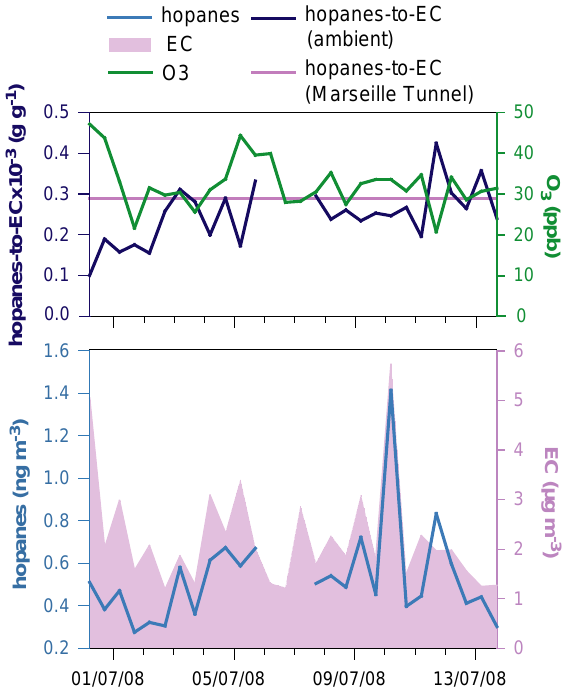
Fig. 9. Time series of EC and sum of hopane (17 α (H)- Fig. 9 21 β (H)-norhopane, 17 α (H)-21 β (H)-hopane and 17 α (H)-21 β (H)- 22S-homohopane). The Ambient concentration ratios of Hopanes- to-EC observed at Marseille (dark blue) are compared to the ratio specific of vehicular emissions in France (green) (El Haddad et al., 2009). Ozone mixing ratio is also plotted as a surrogate for photo- chemical activity. The hopane-to-EC ratios and O 3 show negative correlation consistent with hopane